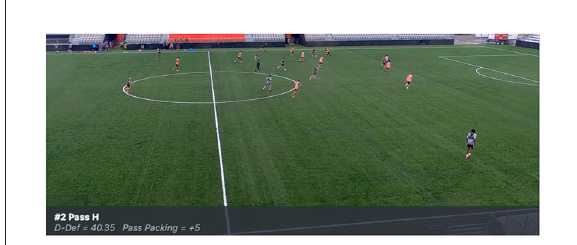
FIGURE1 Example of how players received video feedback for each pass on D-Def and Outplayed Opponents (“Pass